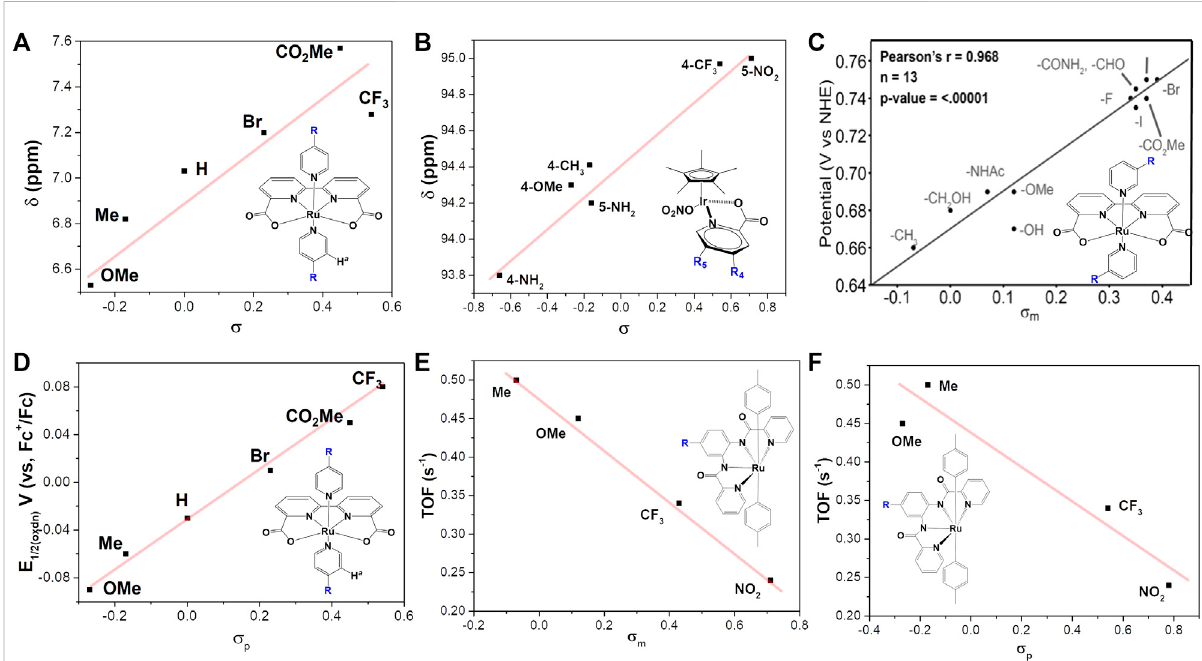
FIGURE 3 Plotof σ -Hammettparameterversus (A) 1 HNMRchemicalshiftofortho-protononthepyridineligands,datafromSatoetal.(2015), (B) 13 CNMR chemical shift of quaternary carbon atom on the Cp, data from Rodriguez et al. (2021), (C) Redox couples Ru III /Ru II , adapt with permission from Angew. Chem. 2021,133,14625 – 14632. Copyright 2021 Angewandte Chemie published by Wiley-VCHGmbH, (D) The oxidation potential of [Ru